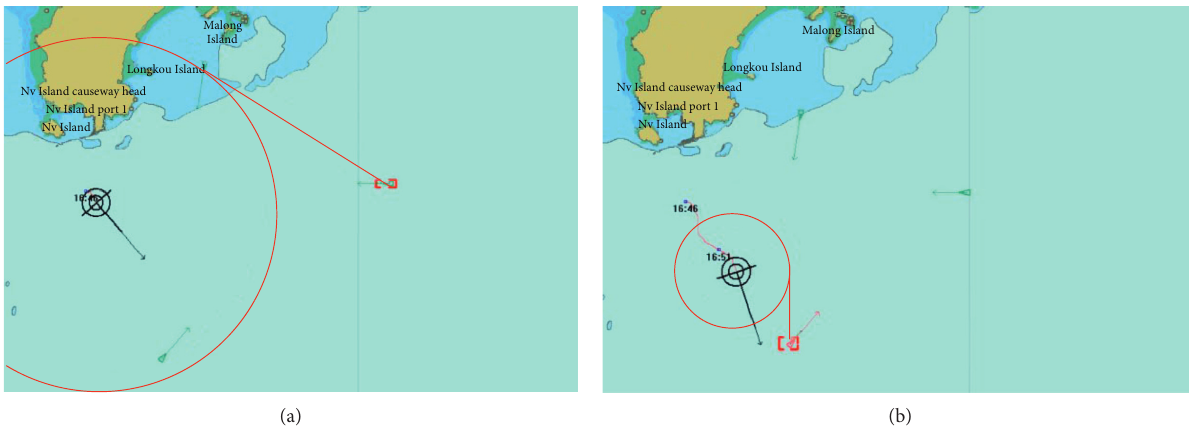
Figure 31: The encounter situation between the ship and the three target ships. (a) Avoid target Ship-1. (b). Avoid target Ship-2.